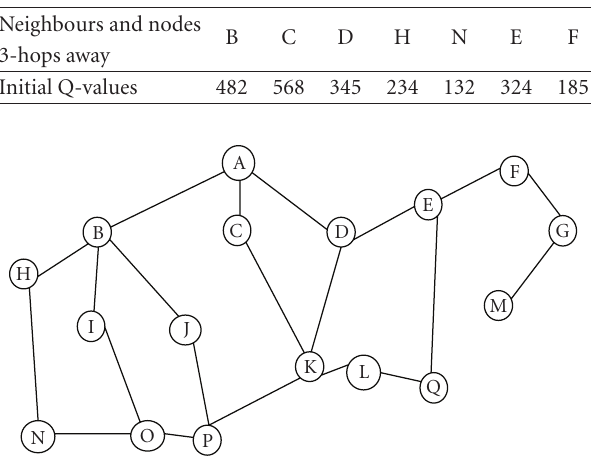
Table 3: A Replication Q-Table.